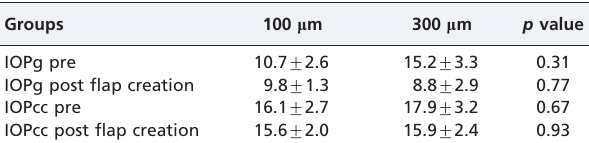
Table 3 - Comparisons between preoperative and post flap creation ( ¡ SD) Goldmann-correlated intraocular pressure (IOPg) and corneal-compensated intraocular pressure (IOPcc) for the 100 m m and 300 m m flap groups with the respective p